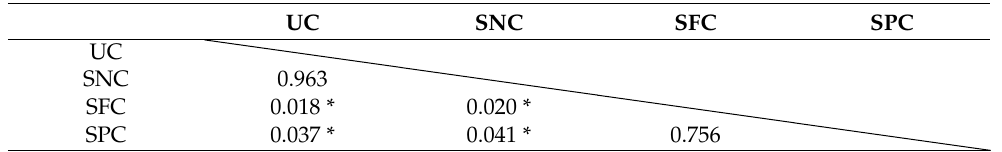
Table 7. Results of pairwise comparison using